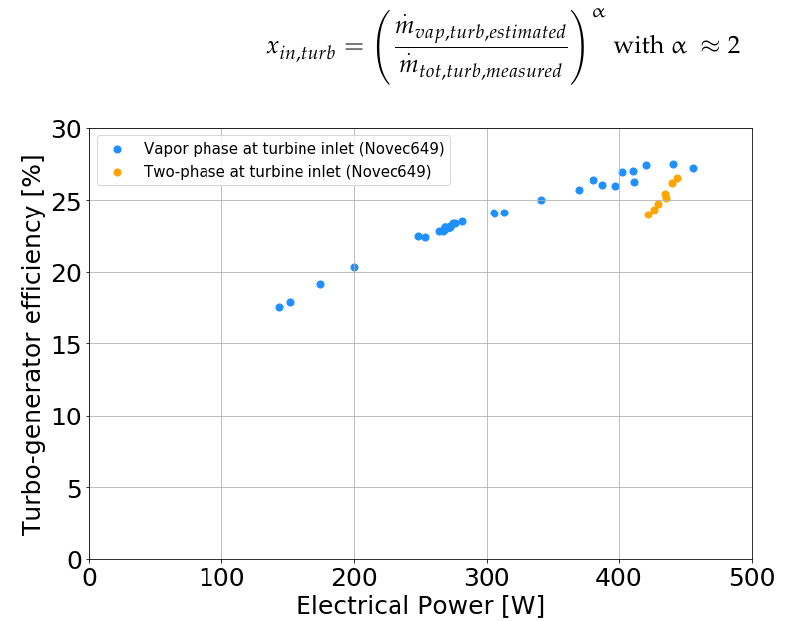
Figure 12. Efficiency based on electrical power.